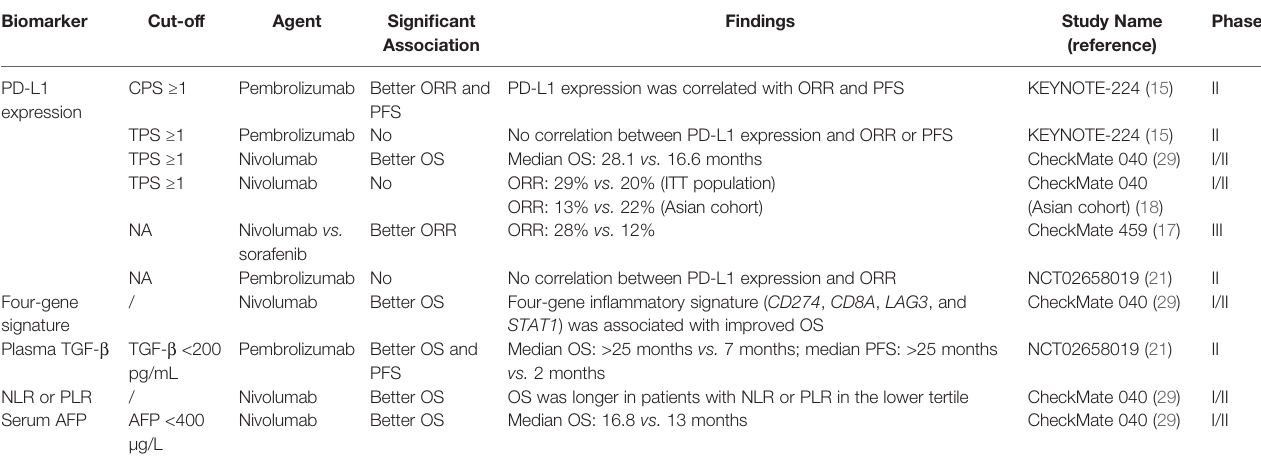
TABLE 2 | Predictive biomarkers in clinical trials of immune-checkpoint inhibitors in hepatocellular carcinoma. Biomarker